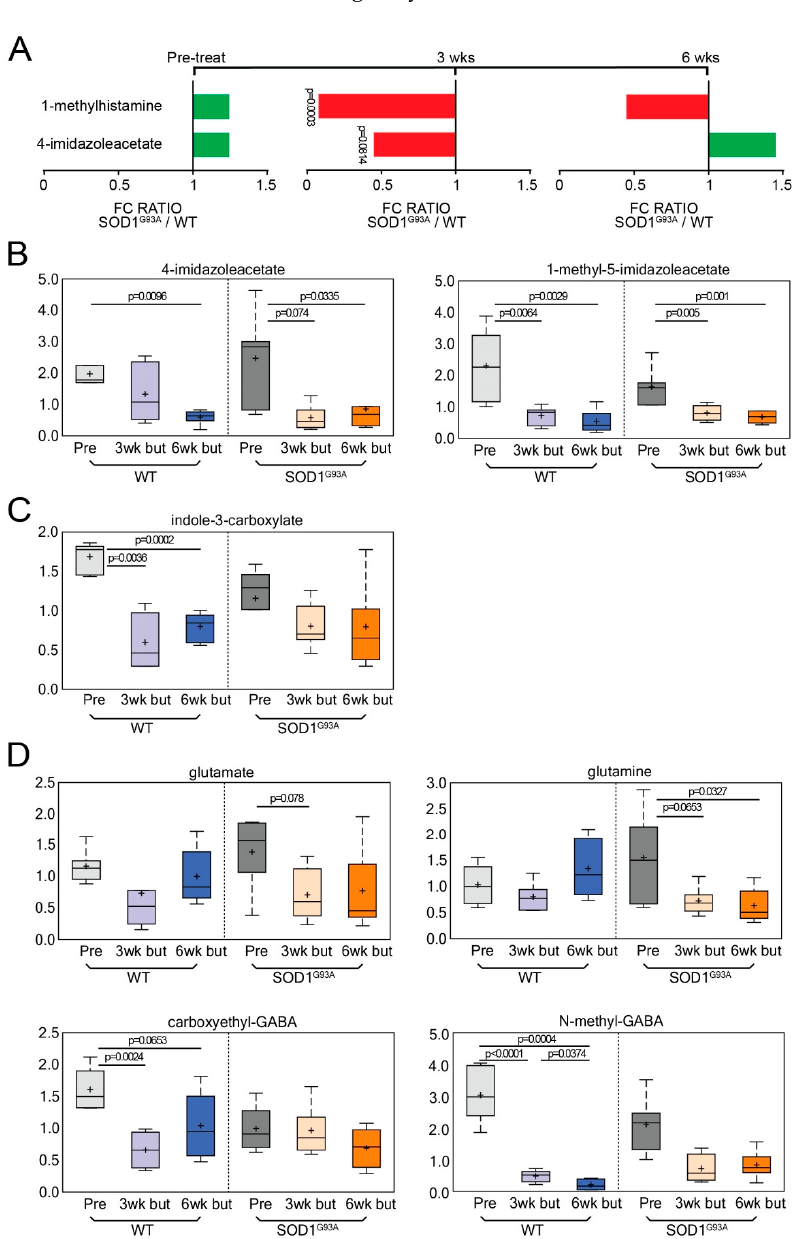
Figure 4. Butyrate (but) treatment altered histamine and tryptophan signaling over the course